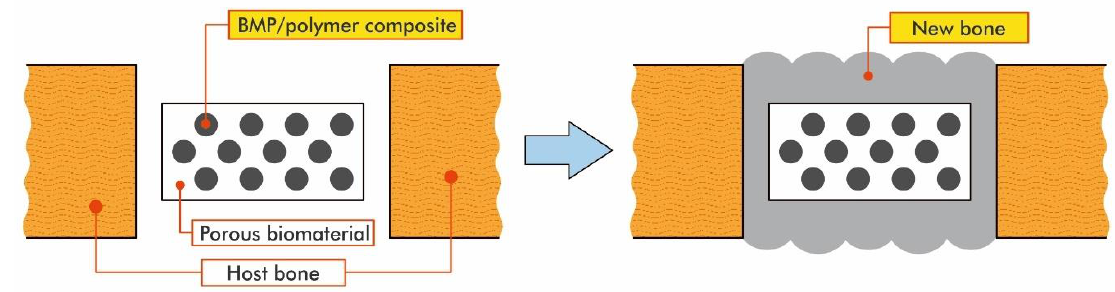
Figure 25. The process of repairing bone defects with the use of BMP/polymer composites [92].